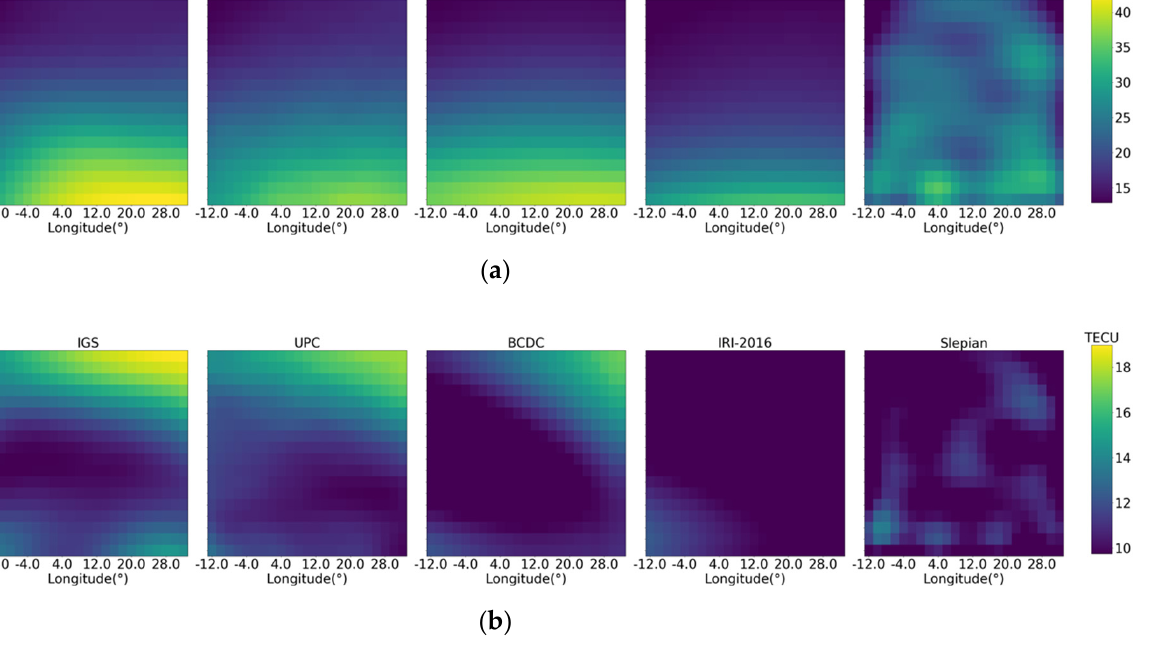
Figure 9. VTEC maps produced by IGS, UPC, BCDC, IRI − 2016 and Slepian during the geomagnetic quiet time. ( a ) 12:00, 16 June; ( b ) 2:00, 21 June.